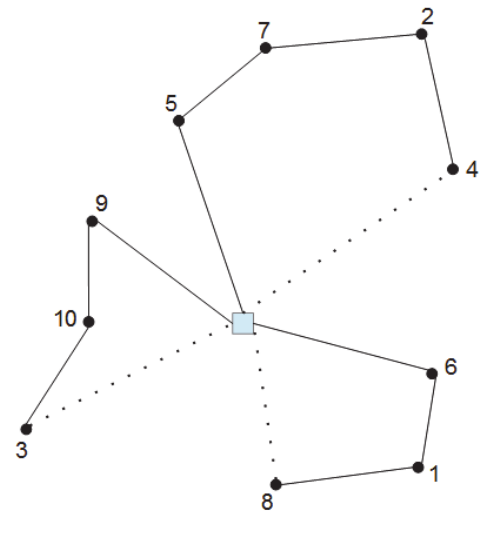
Fig. 1. Typical topology of a VRP